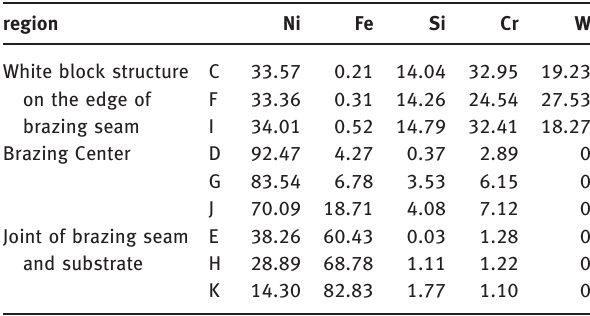
Table 2: Phase element composition (wt.%). region Ni Fe Si Cr W White block structure on the edge of